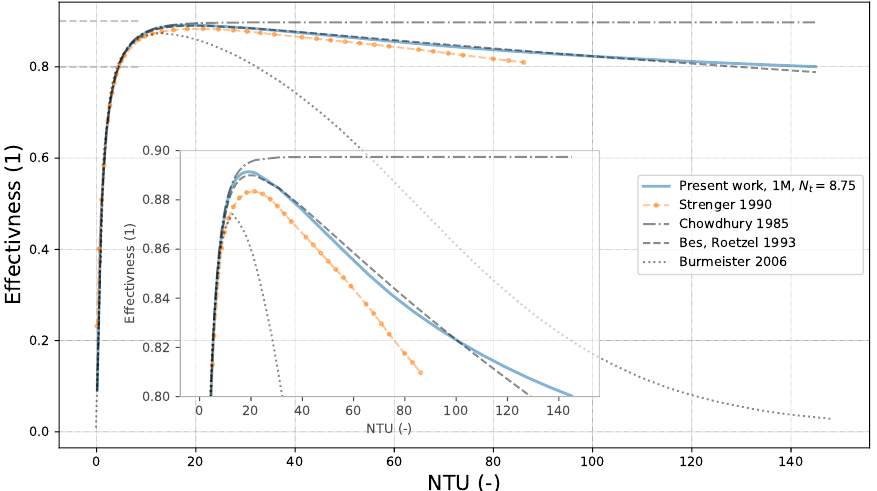
Figure 4. Prediction of the effectiveness parameter for a one-module (1M) SPHE in comparison to results from the